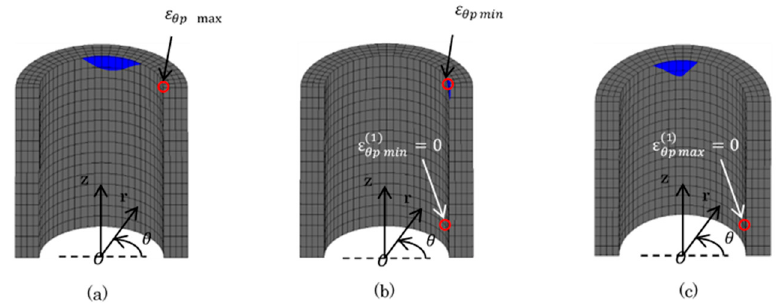
Figure 14. Plastic region of bush ( σ yield = 1390 MPa : plastic region): ( a ) press-fitting state; ( b ) tensile state; ( c ) sprocket-engaging state.